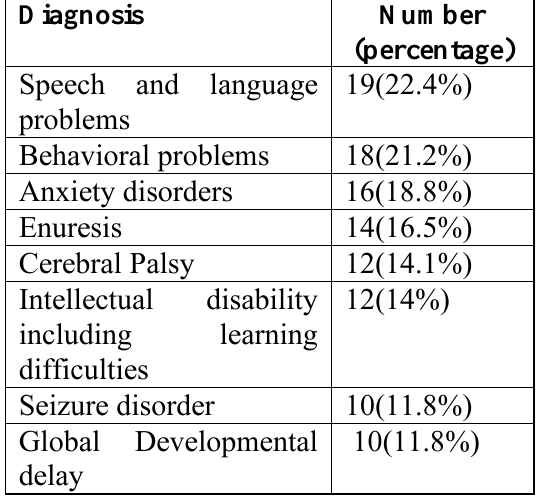
Table 2: Diagnosis using different tools And clinical evaluation